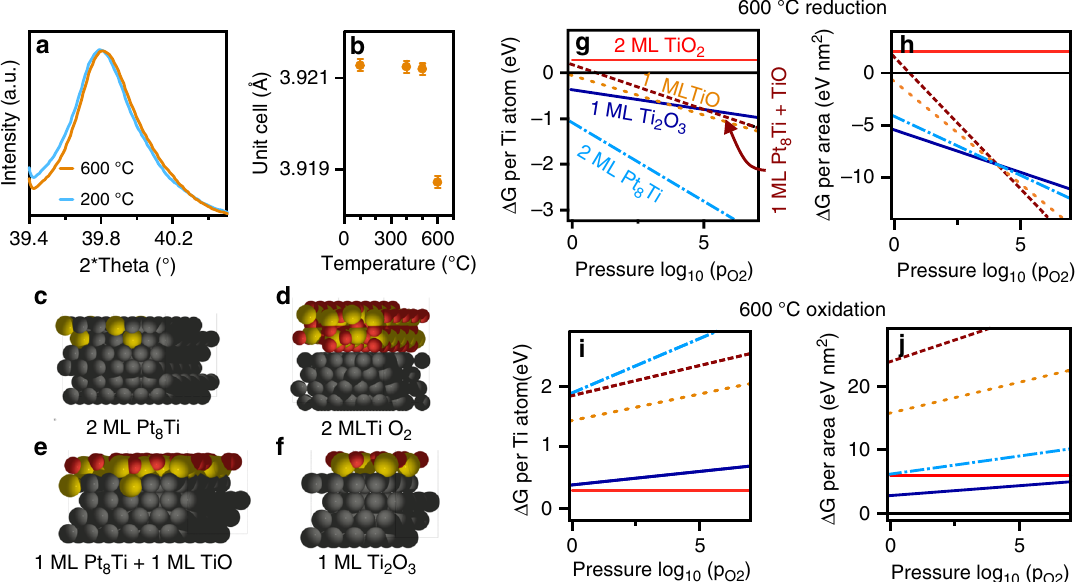
Fig. 4 Formation of the strong metal-support interaction (SMSI) state. In situ X-ray diffraction ( a ) acquired at 100 °C at 1 bar in a fl ow of hydrogen after treatment at two temperatures (200 and 600 °C) and corresponding Pawley fi tting for the platinum unit cell after different hydrogen reduction temperatures for 1 h ( b ). The error bars represent one standard deviation of the mean. DFT surface models for different types of platinum surface coverage ( c – f ). The global minimum for the calculated structures at 600°C as a function of the hydrogen ( g ) and oxygen pressure ( i ) as well as the thermodynamic stability per surface area in the case of a fi nite number of Ti atoms that may be released by the bulk, as is the case for a kinetic barrier ( h , j